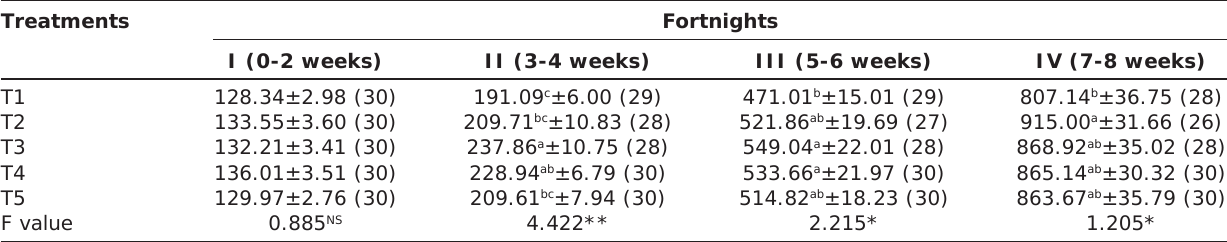
Table-1: Effect of phytobiotics-containing herbal seeds as feed supplements on overall body weight (g) at fortnight in turkey poults. Treatments